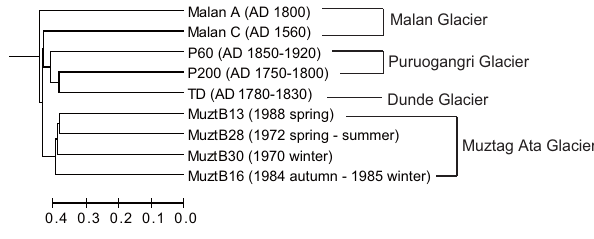
Fig. 5. Hierarchical cluster showing the overall phylogenetic dif- ferences amongst bacterial communities from four geographically isolated glaciers Puruogangri (two clone libraries containing the forward portion of 16S rRNA gene sequence corresponding to 8 to ∼ 800 of Esherichia coli 16S rRNA molecule, with sequence accession number AY313907-AY313917, DQ076421-DQ076430, and DQ076441-DQ076444, Zhang et al., 2009), Dunde (with se- quence accession number AY313918, AY313919 and DQ076445- DQ076456, Zhang et al., 2009), Malan (two clone libraries contain- ing > 7 unique clones with sequence accession number AY322483- AY322489 in Xiang et al., 2004 and AY121823-AY121830 in Zhang et al., 2009) and Muztag Ata (this study). UniFrac scale indicated differences amongst the bacterial